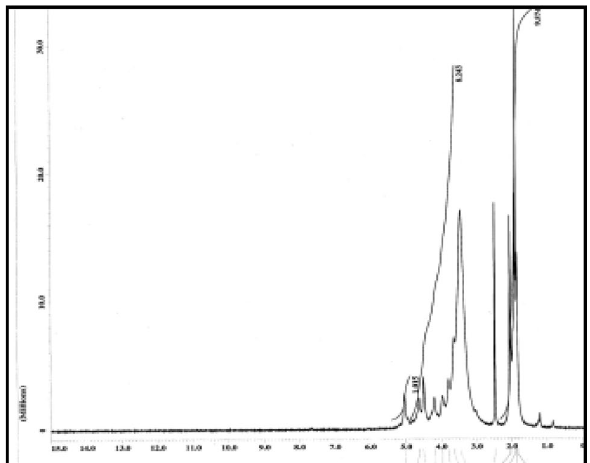
Figure 4. 1 H-NMR of Nanocellulose acetate prepared from